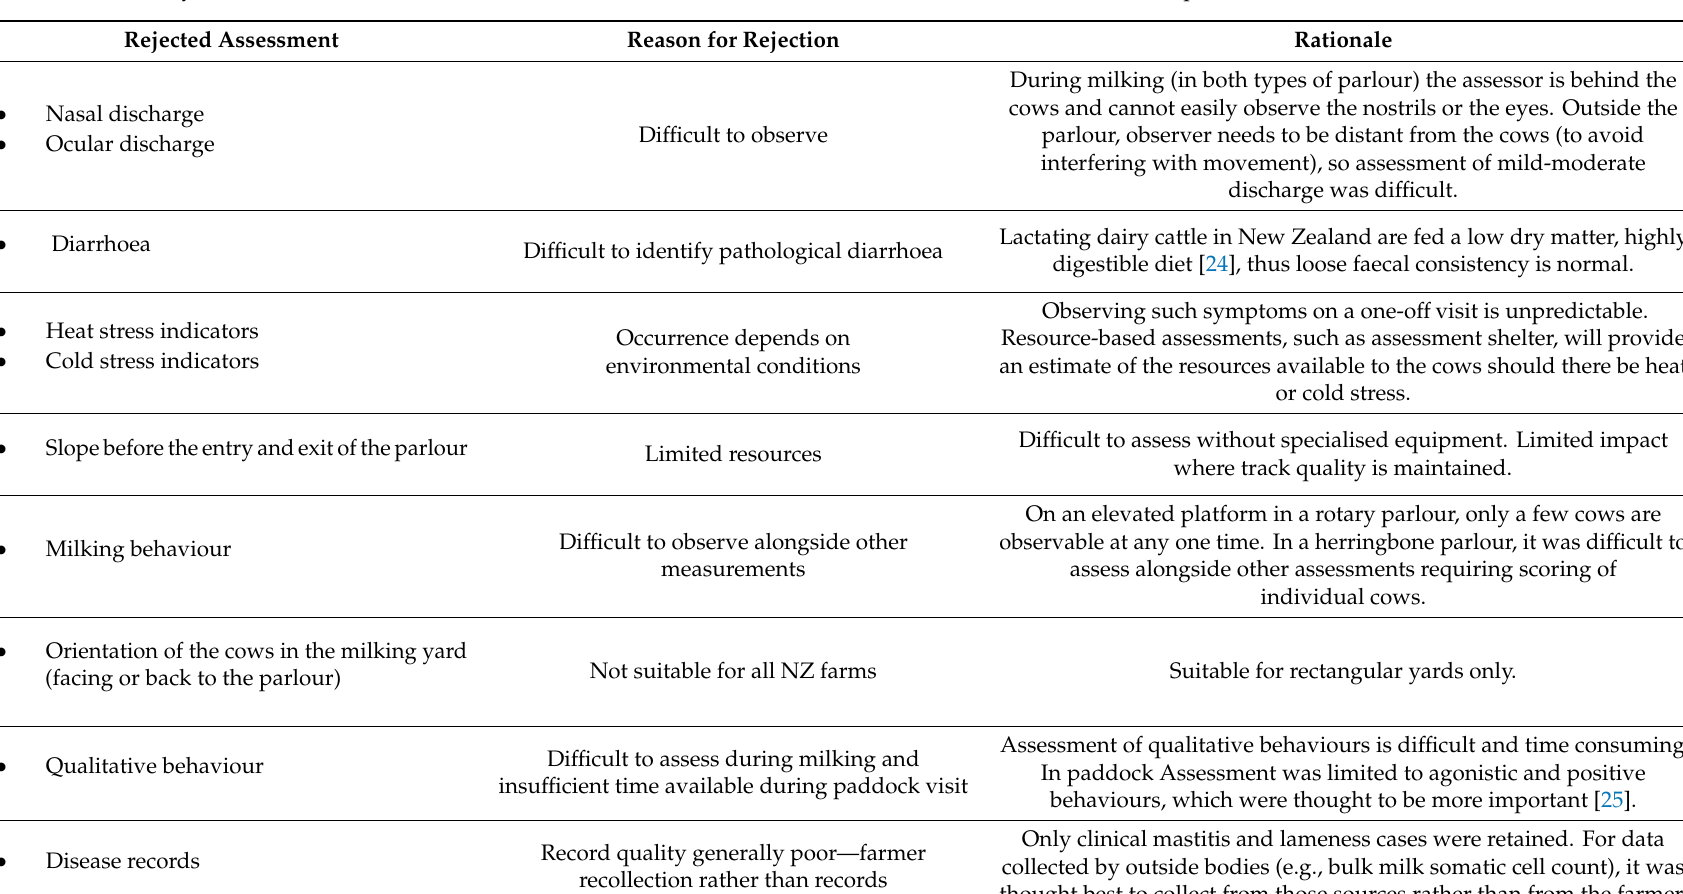
Table 1. Dairy cow welfare assessments that were trialled on-farm but excluded from the final welfare assessment protocol and the rationale for their